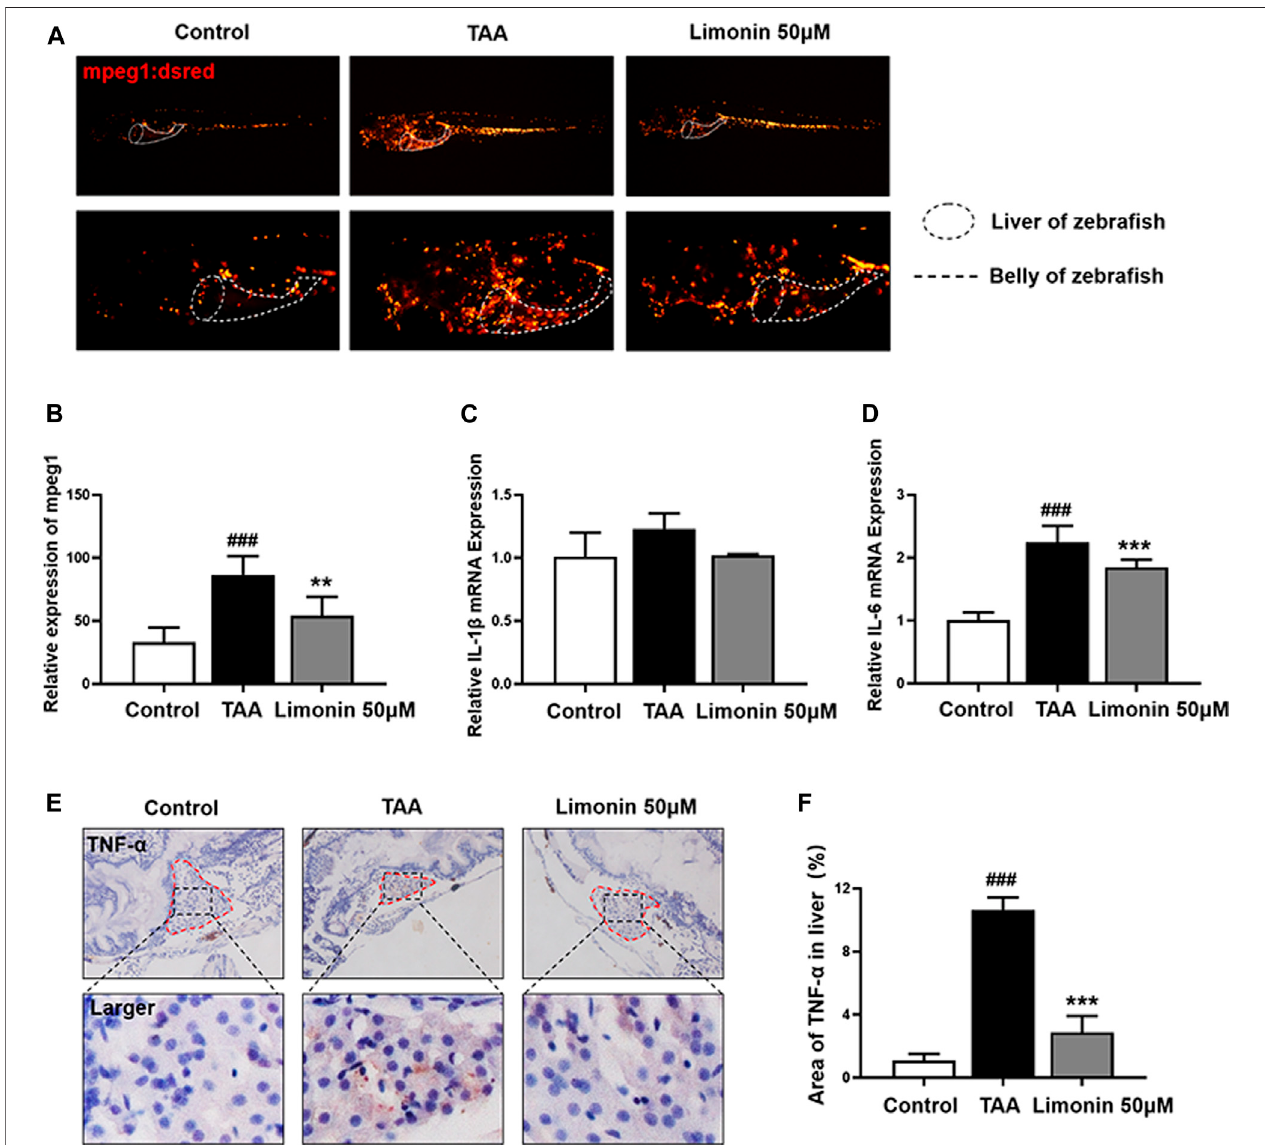
FIGURE 6 | Limonin reduced liver in fl ammatory damage caused by TAA. (A) Limonin reduced the in fi ltration of macrophages in the liver of zebra fi sh during TAA exposure.Figures aremagni fi edas × 25and50 × ( n (cid:1) 6pergroup). (B) Relativeexpression ofmpeg1 inzebra fi shliver. (C,F) ImmunohistochemicalstainingofTNF- α and F4/80inparaf fi nsections ofzebra fi shlarvae( n (cid:1) 4pergroup). (D,G) Quantifythe fl uorescence intensityofTNF- α andF4/80proteins. (E,H) Real-timePCRanalysisofIL- 1 β and IL-6 mRNA levels in zebra fi sh larvae. The mRNA levels were normalized to β -actin mRNA levels and presented as fold change compared with the control group ( n (cid:1) 3 per group). Data are shown as the mean ± SD. # p < 0.05, ## p < 0.01, ### p < 0.001 vs control group; * p < 0.05, ** p < 0.01, *** p < 0.001 vs TAA group.